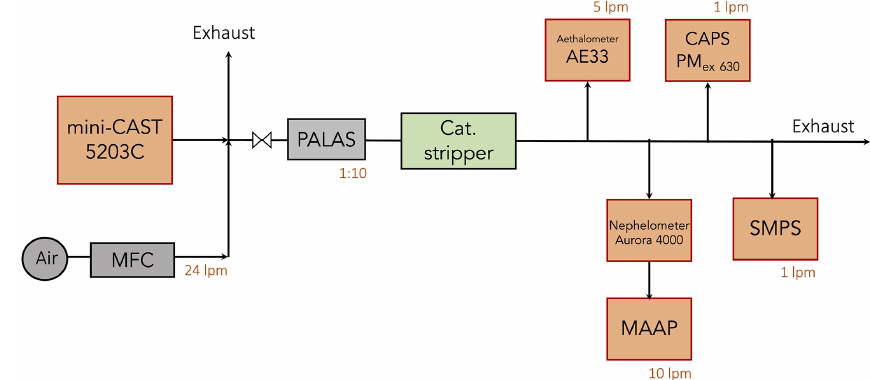
Figure A1. Experimental setup of E1: generation and measurements of denuded BC particles. The soot generator miniCAST 5203C was used to generate the particles under different operating conditions given in Table 1. A mass flow controller (MFC) was used to mix the aerosols generated from miniCAST 5203C with air, and then a catalytic stripper at 350 ◦ C was used to remove the volatile contents. The heated black carbon particles were divided into four aerosol flows and delivered to instruments. The different instruments measuring the physical and optical properties are mobility particle size spectrometer (MPSS), cavity-attenuated phase shift extinction monitor (CAPS PM ex630 ),